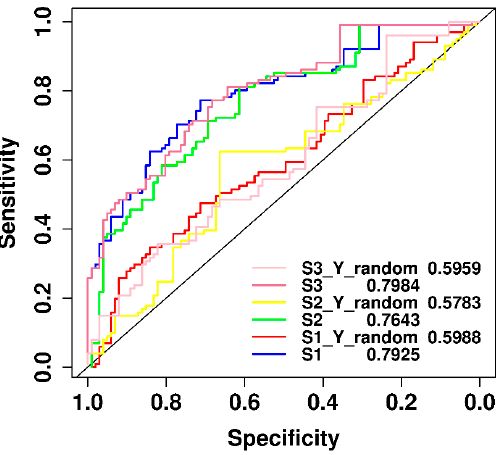
Figure 5. Performance comparison between the original models (S1, S2, S3) and the models with